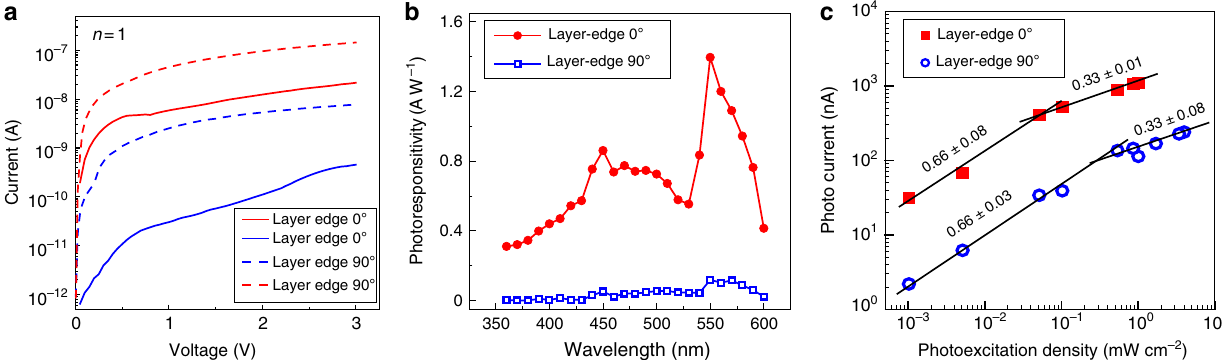
Fig. 2 Transport properties of layer-edge device with n = 1. a I – V curve in dark and photo environment under white light with the power of 1 mW cm − 2 . I d is dark current and I p is photo current for layer-edge 0° and 90° devices. b Photo responsivity vs wavelength. The light power density is 10 mW cm − 2 . c Photo current vs photoexcitation density in layer-edge 0° and 90° devices. The bias voltage is fi xed at 3 V in b and